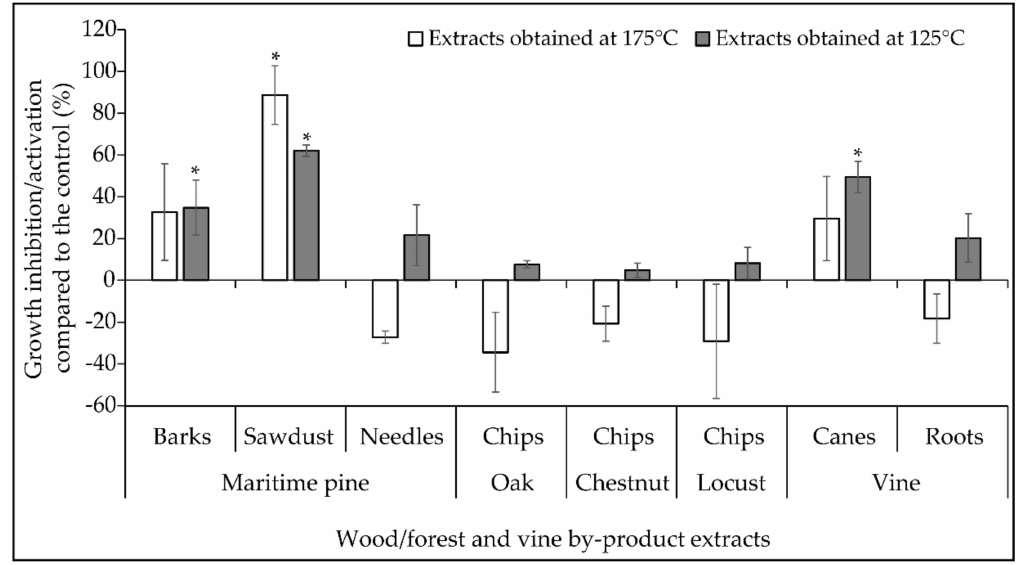
Figure 2. Percentage of inhibition/activation of the radial growth of Fusarium graminearum by the natural extracts obtained at 175 ◦ C (white bars) and extracts obtained at 125 ◦ C (gray bars). Data are means ± standard deviation using three biological replicates. Asterix (*) indicates significant differences when compared with control (Student’s t test, control versus treated, p < 0.05). The inhibitory activity of extracts was calculated according to the following formula: percentage of mycelial growth inhibition % = [(area in control culture − area in extract-amended culture)/area in control culture] ×